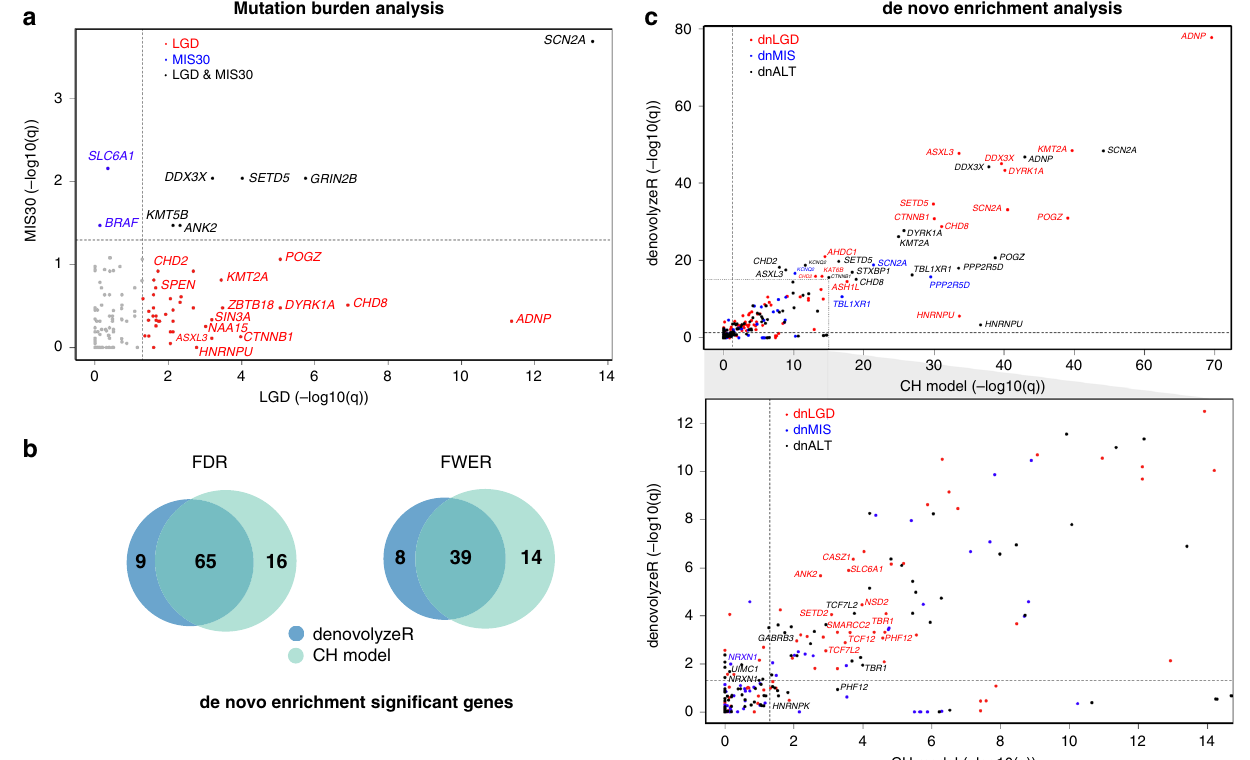
Fig. 2 Signi fi cant genes identi fi ed from mutation burden and de novo enrichment analyses. a Mutation burden analysis identi fi ed 48 genes signi fi cant for LGD and/or MIS30 variants in smMIP sequencing compared with the ExAC (r0.3) non-psych subset controls; each dot indicates a gene and the color indicates the category of variant showing signi fi cance for the gene (red for LGD, blue for MIS30, and black for both LGD and MIS30). b The CH model and denovolyzeR show high concordance for genes with signi fi cant excess of DNM at both FDR and FWER levels. c A union set of 90 genes showing excess DNM (FDR 5%) in de novo enrichment analysis. Gray dashed box in top panel is shown in bottom panel for a zoom view. See Supplementary Data 10 for underlying